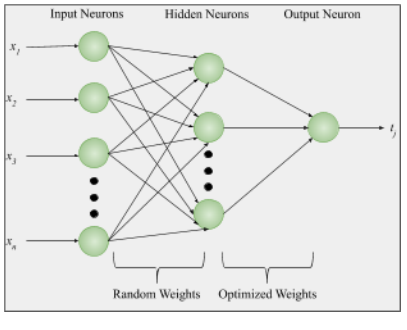
Figure 4. ELM Model (Yang, et al, 2011)